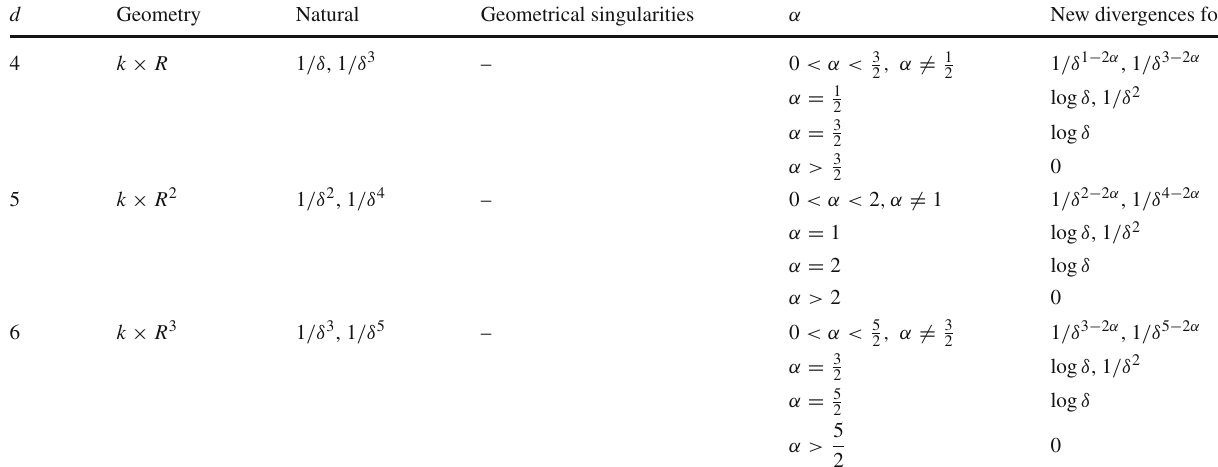
Table 5 Complexity for k × R l